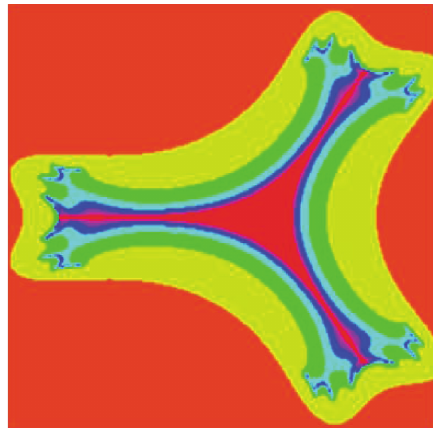
Figure 8: Relative superior multicorn for 𝑠 = 0.3 and 𝑠 󸀠 = 0.5 .